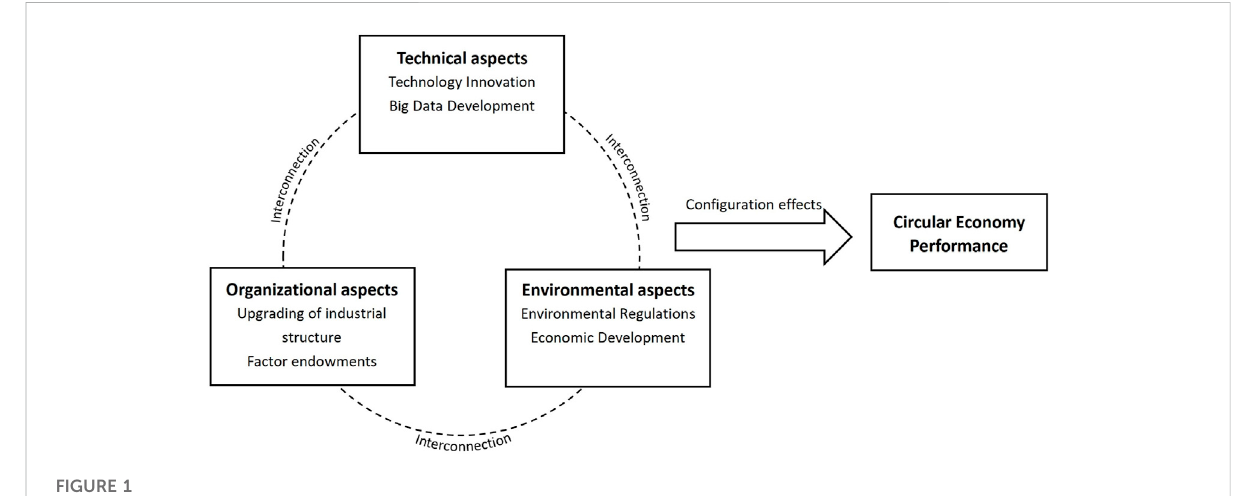
FIGURE 1 Research